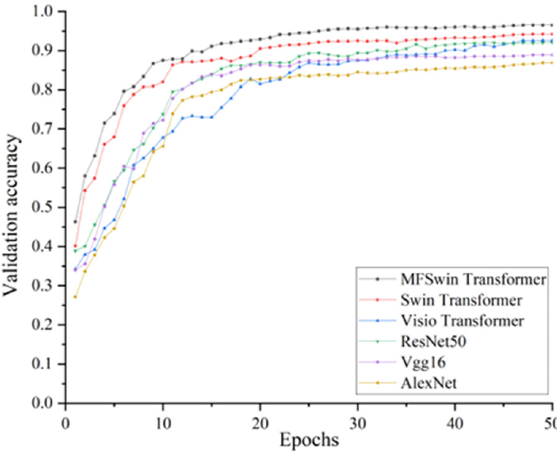
Figure 15. Relationship between model verification accuracy and iteration rounds.